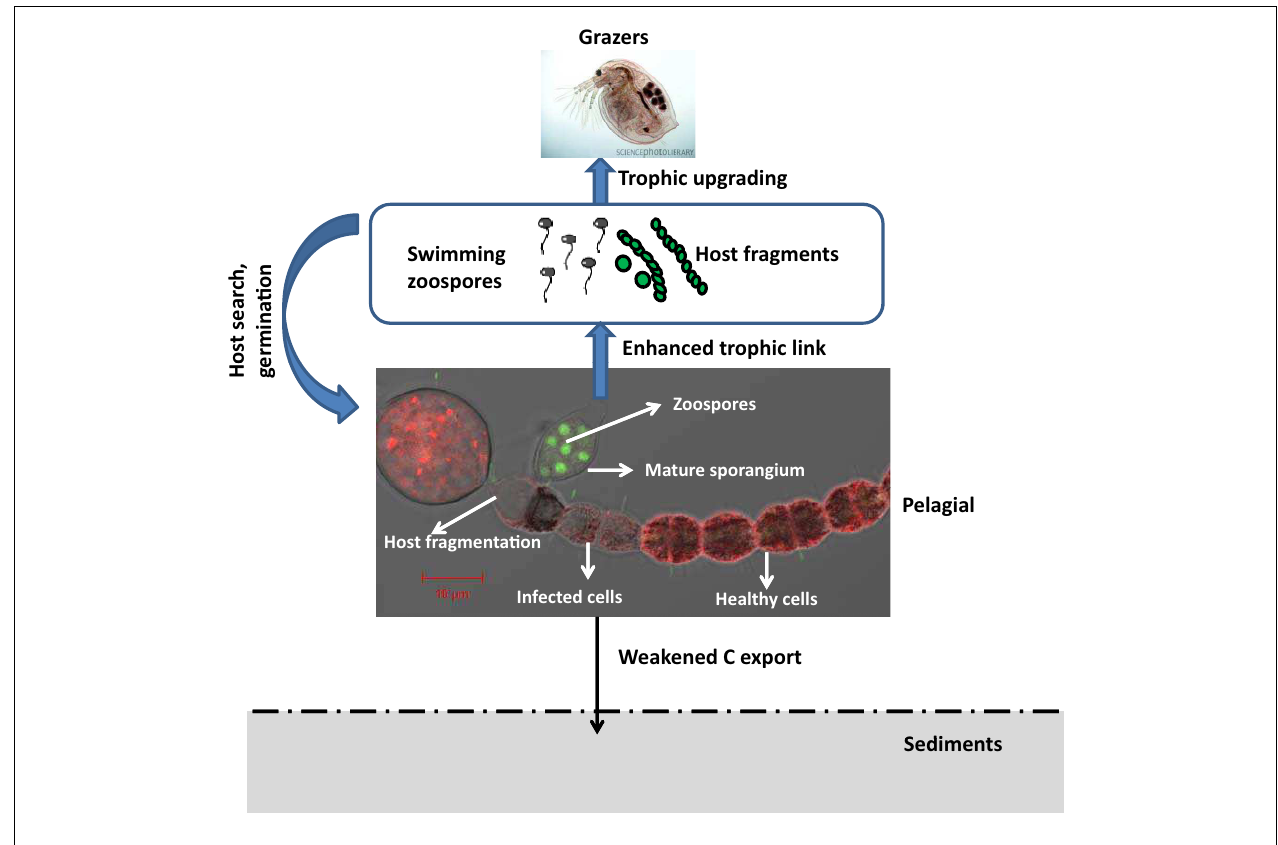
represent trophic bottleneck to be sequestered in the sediments. Part of their energy are retained in the pelagial and recycled through the trophic cascade. Source for Daphnia zooplankton micrograph is the science photo library: http://www.sciencephoto.com/media/367262/enlarge.The microphotograph of infected A. macroscopra filament with Cytox Green stained zoospores observed under confocal microscopy is a courtesy of Melanie